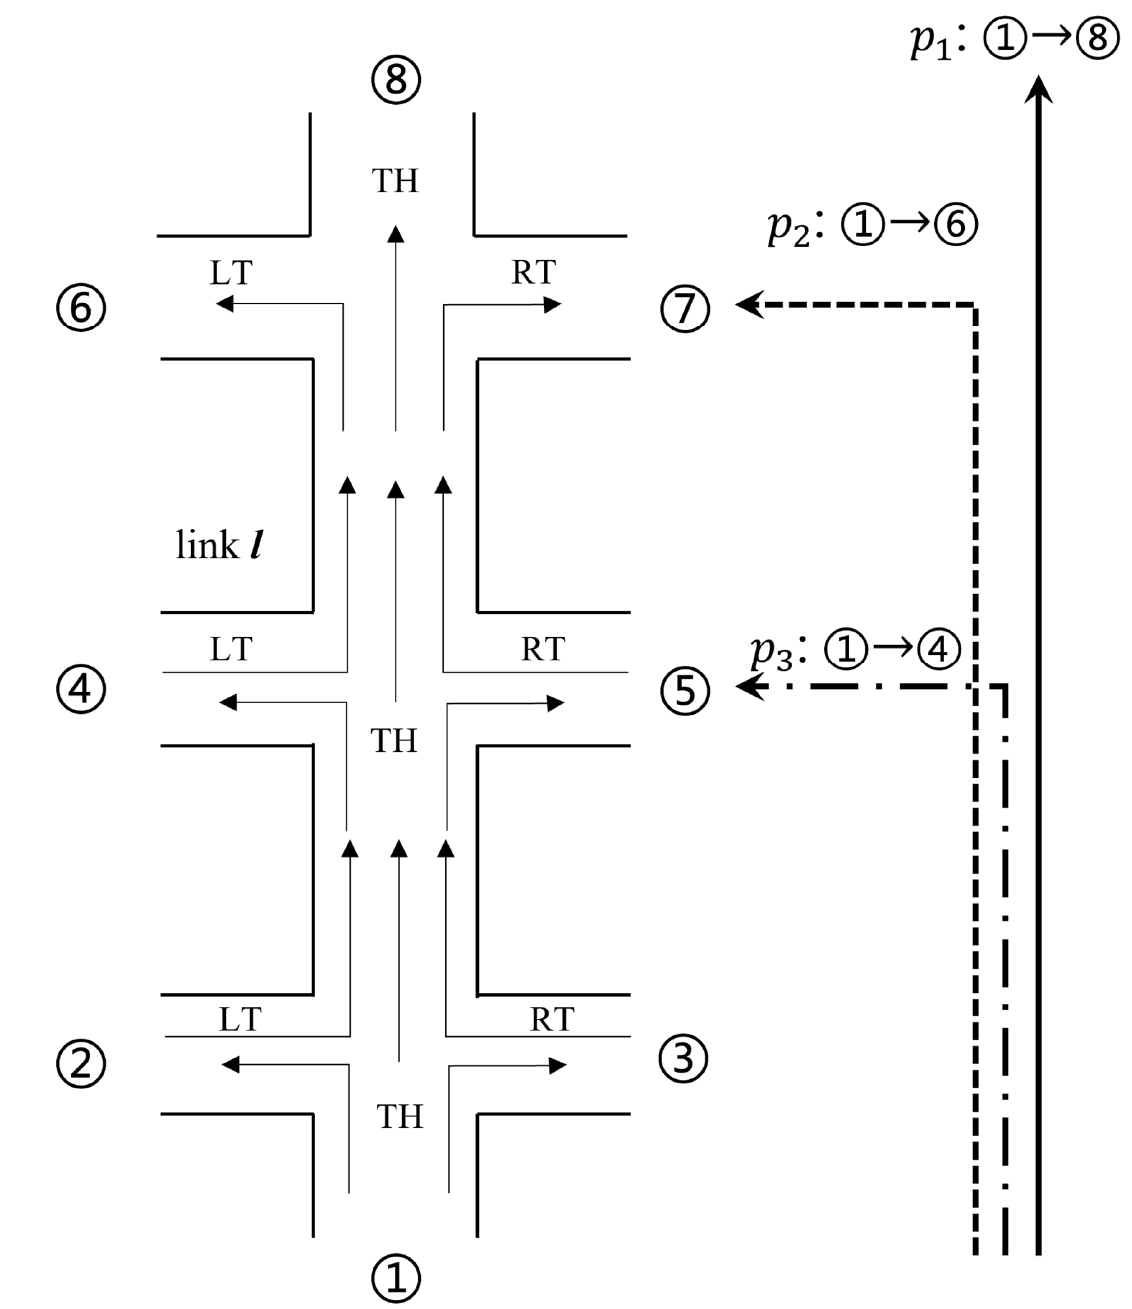
Figure 3. Upstream inflows and downstream outflows form a path.